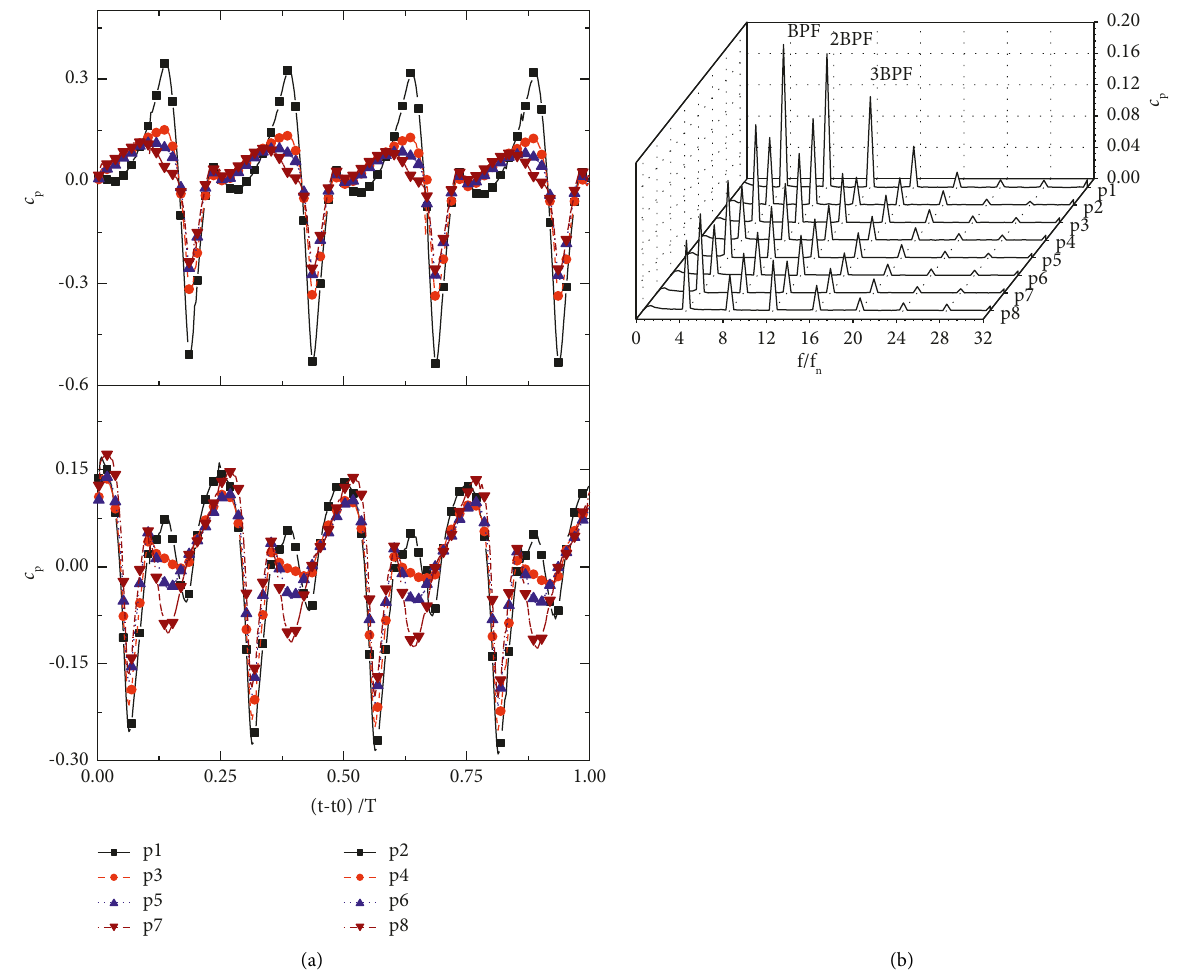
Figure 6: Pressure fluctuation and frequency spectra distribution at selected monitoring points. (a) Pressure fluctuation and (b) pressure spectra.